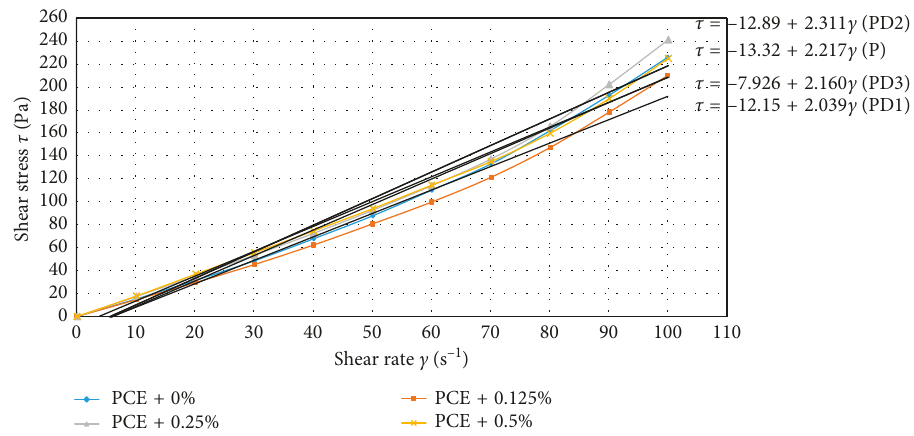
Figure 9: Flow curves of nanomodified cement pastes with PCE after 120min of mixing.